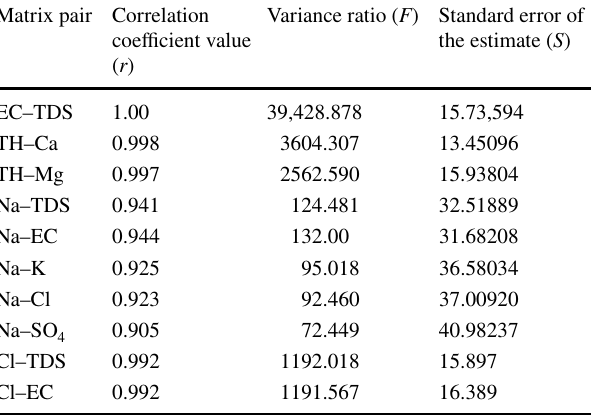
Table 5 Correlation coefficient for significant water quality param- eters, variance ratio ( F ) and standard error of the estimate ( S ) Variance ratio ( F ) Standard error of Matrix pair Correlation the estimate ( S ) coefficient value ( r )